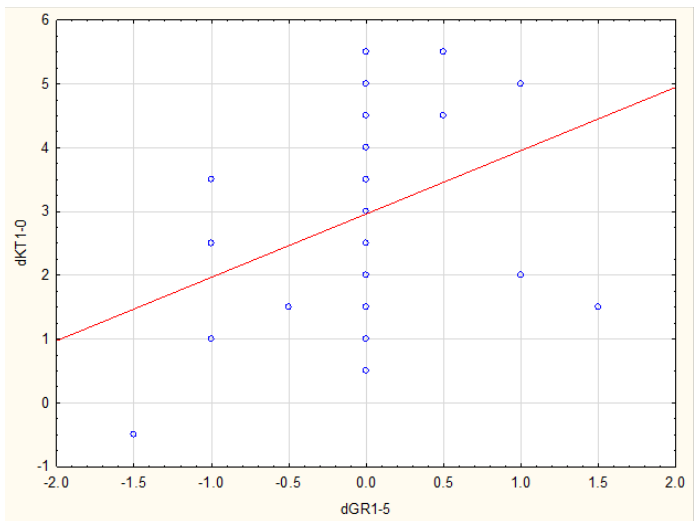
Figure 3. Correlation between KT width one year after procedure and GR changes between exami- Figure 4. Correlation between KT-width increase one year after procedure and GR changes between nation after one year and five years on the SCTG side. examination after one year and five years on the SCTG